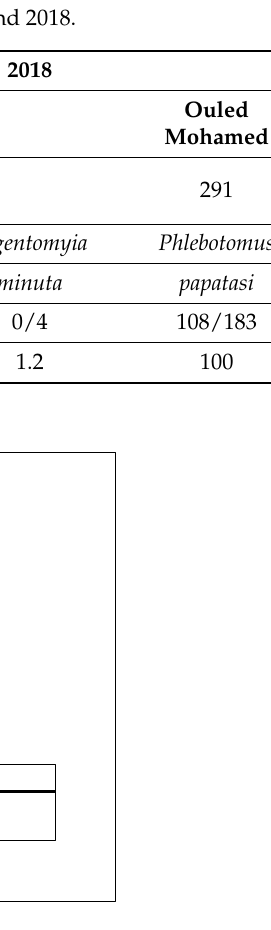
Table 1. Sandfly fauna collected in Hichria and in Ouled Mohamed in 2017 and 2018.